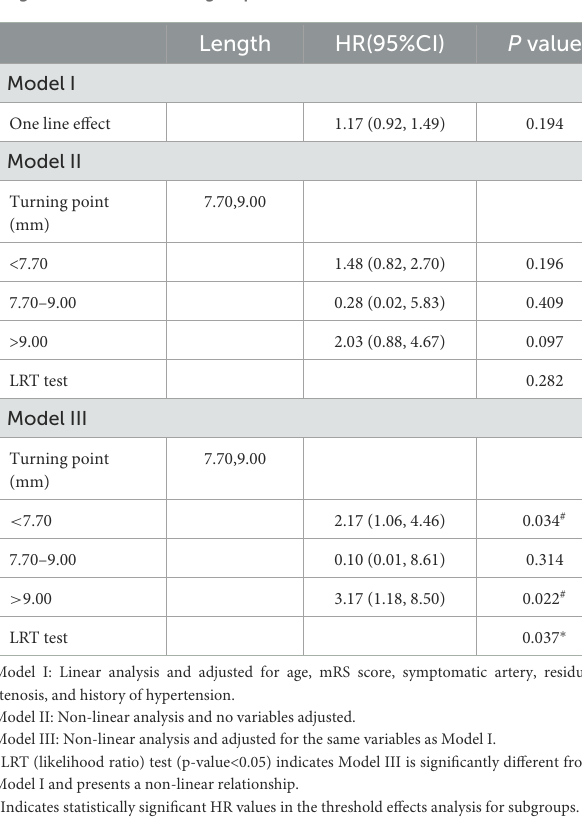
TABLE 5 Threshold effect analysis for the relationship between lesion length and RCI in the SES